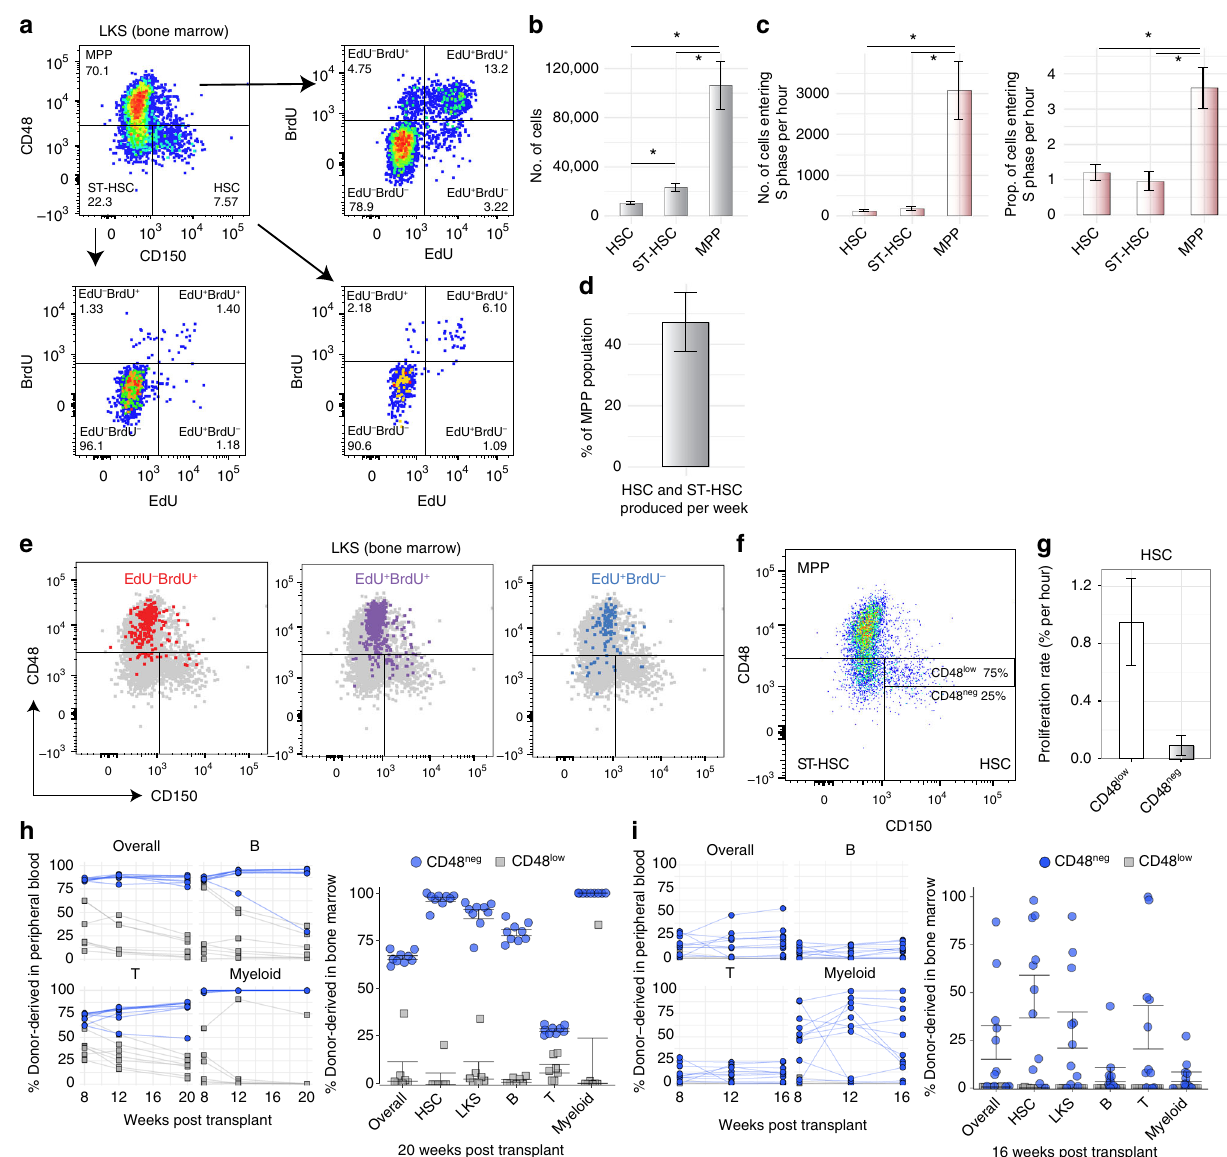
Fig. 4 EdU-BrdU dual pulse reveals instantaneous rate of entry into S phase of primitive haematopoietic cell populations in steady-state conditions. a Representative FACS plot of LKS cells, showing HSC, ST-HSC and MPP populations and their relative FACS plots of EdU and BrdU incorporation patterns. b Total number of HSCs, ST-HSCs and MPPs in BM from one hind leg. c Number (left) and proportion (right) of HSCs, ST-HSCs and MPPs entering S phase per hour (average ± s.e.m shown; left, p = 0.252 HSC to ST-HSC, p = 0.002 HSC to MPP, p = 0.003 ST-HSC to MPP, Welch ’ s two-sample t -test; right, p = 0.509 HSC to ST-HSC, p = 0.004 HSC to MPP, p = 0.002 ST-HSC to MPP, Welch ’ s two-sample t -test; n = 15 mice analysed). d Number of cells produced per week by HSCs and ST-HSCs compared with MPP population size based on the data presented in b and c (average ± s.e.m. shown). e Representative FACS plot of LKS cell population, highlighting the phenotype of EdU − BrdU + , EdU + BrdU + and EdU + BrdU − cells. f Representative FACS plot showing gates separating HSCs with the lowest 25% expression levels of CD48 (CD48 neg ) and the higher 75% (CD48 low ). g Proportion of CD48 low and CD48 neg HSCs entering S phase per hour based on EdU and BrdU uptake (average ± s.e.m shown; p = 0.019, Welch ’ s two-sample t -test; n = 10 mice). h Transplantation of mTomato + CD48 neg and CD48 low HSCs into lethally irradiated recipients. Left panel: time-course of engraftment at weeks 8, 12 and 20 (data, mean ± s.e. m shown; p < 10 − 4 overall, B, T and Myeloid, exact one-way permutation test for mean difference between groups; n = 9 and n = 7 mice, respectively). Right panel: bone marrow engraftment at week 20. i Secondary transplantation of mTomato + CD48 neg and CD48 low HSCs into lethally irradiated recipients. Left panel: time-course of engraftment at weeks 8, 12 and 16 (data, mean ± s.e.m shown; p < 10 − 4 overall, B, T and Myeloid, exact one-way permutation test for mean difference between two groups with n = 11 mice each). Right panel: bone marrow engraftment at week